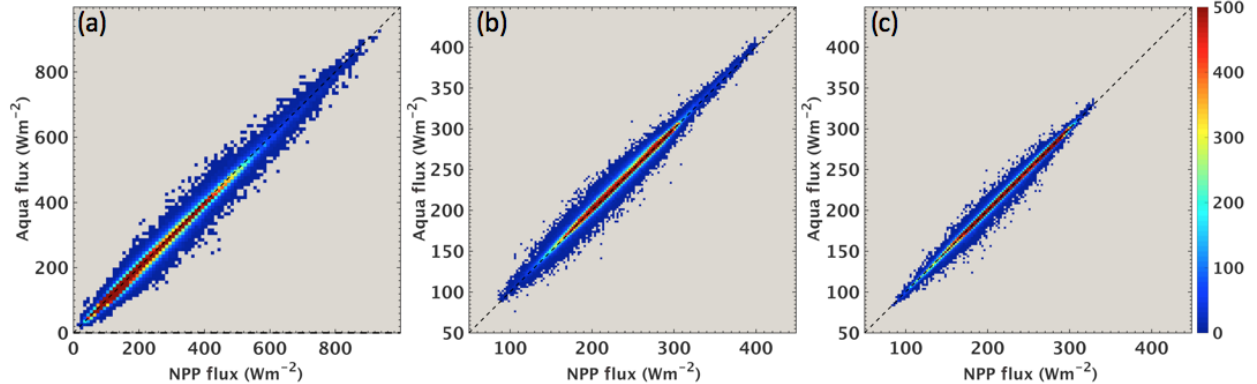
Figure 2. Flux comparisons between matched Aqua CERES and NPP CERES footprints – (a) SW, (b) daytime LW, and (c) nighttime LW using data from 2013 and 2014. The total number of footprints, the mean fluxes, and the flux RMS errors are summarized in Table 1.